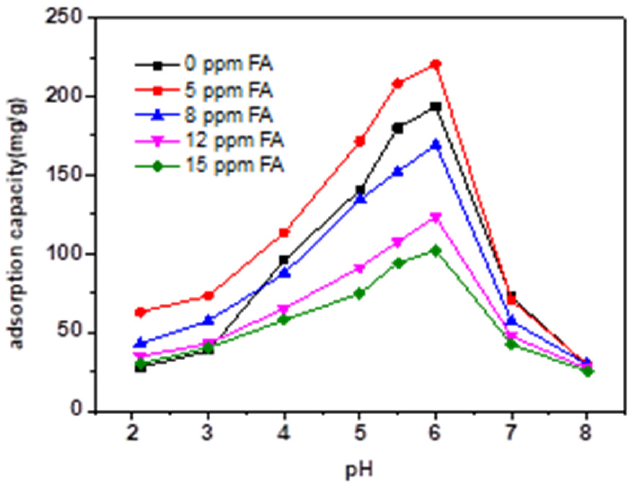
Figure 8. The FA concentration at the end of the experiment as a function of pH.